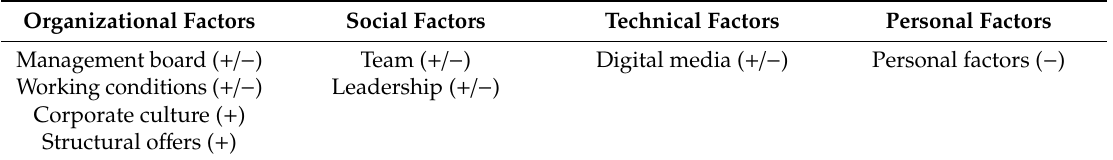
Table 4. Factors influencing the application of health-oriented